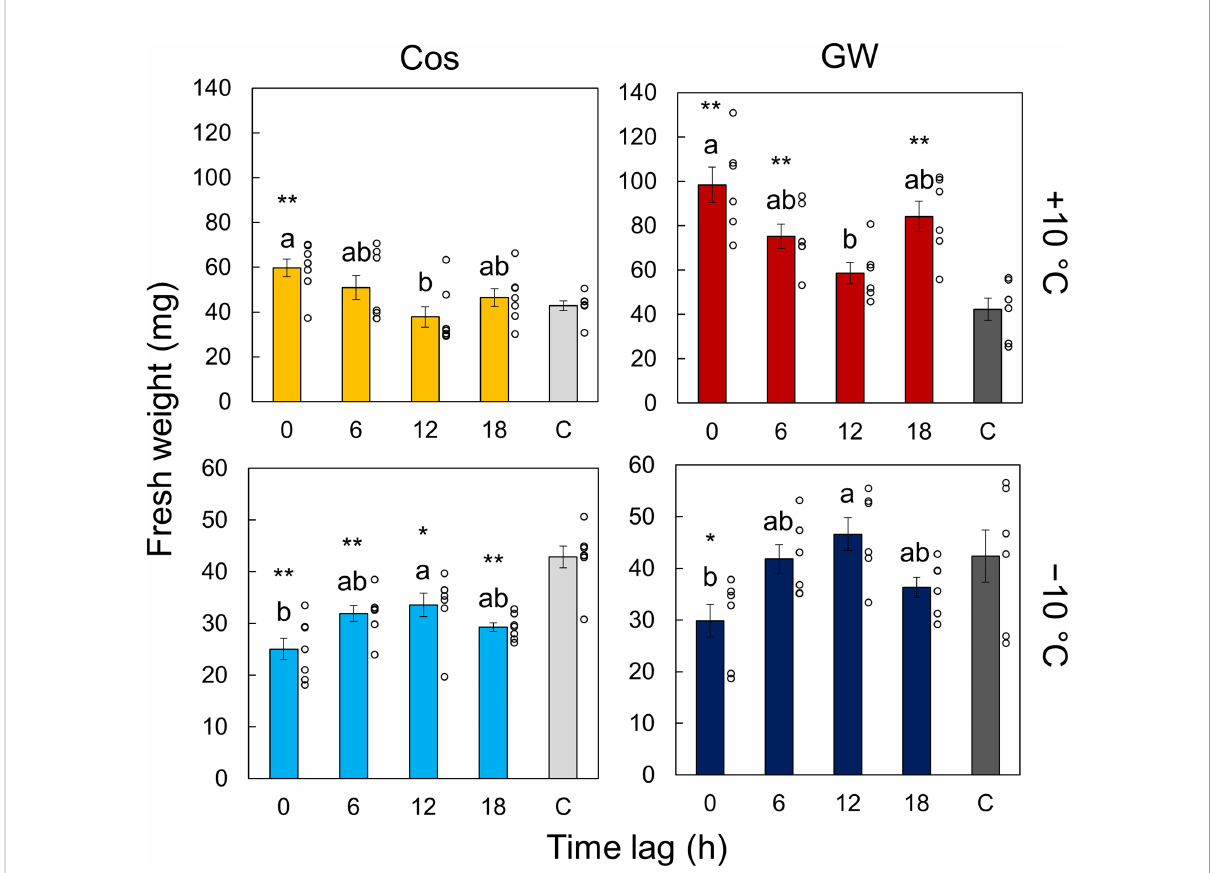
FIGURE 4 Effect of the time lag on plant growth. The control condition is labeled C. Each data point is the mean of n = 7 individuals in leaf lettuce ( Lactuca sativa L.) ‘ Cos ’ and 6 in ‘ GW ’ . Error bars indicate standard error. The circles indicate the individual data points. Two conditions that do not have the same letter indicate signi fi cant differences for each panel (Tukey-Kramer test, p < 0.05). Asterisks indicate signi fi cance differences with the control condition (Welch ’ s t -test, * p < 0.05, ** p <